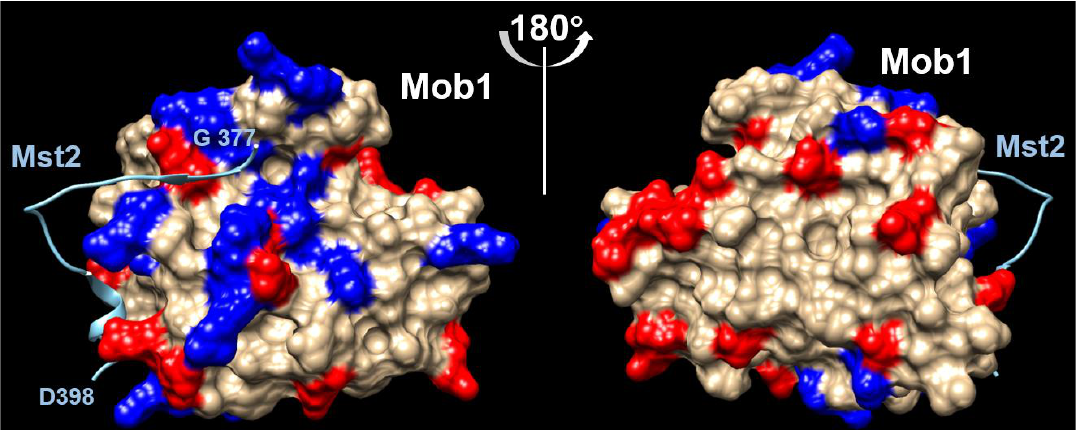
Figure 5. Interaction of Mob1 with Mst2. The blue ribbon represents a fragment of Mst2 interacting with Mob1. Positively (blue) and negatively (red) charged residues in the surface of Mob1 are indicated. Left and right show 180° rotated views of Mob1. The site in Mob1 surrounding the N-terminal of the interacting Mst2 fragment displays many positively charged residues, unlike the opposite side of the molecule. Using the modified PDB from the DIBS database (DI1000206 [28]).